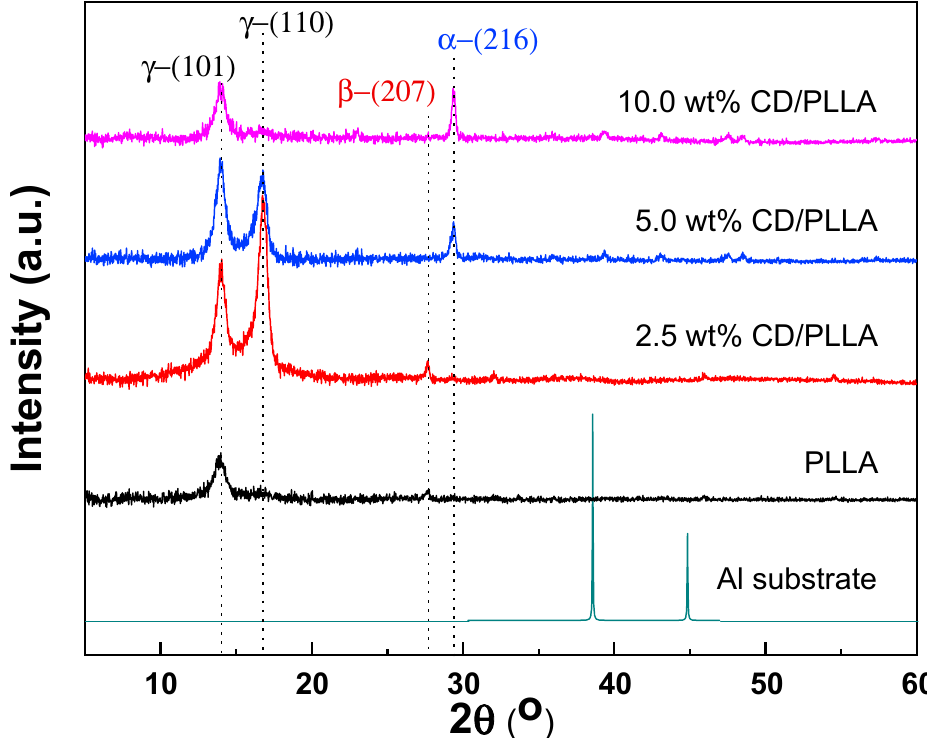
Figure 3. XRD pattern of PLLA and CD/PLLA nanofibers.